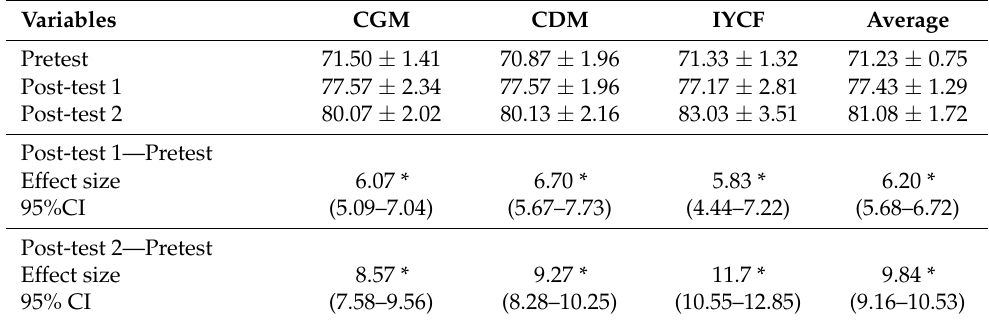
Table 2. The impact of short course on cadre knowledge.